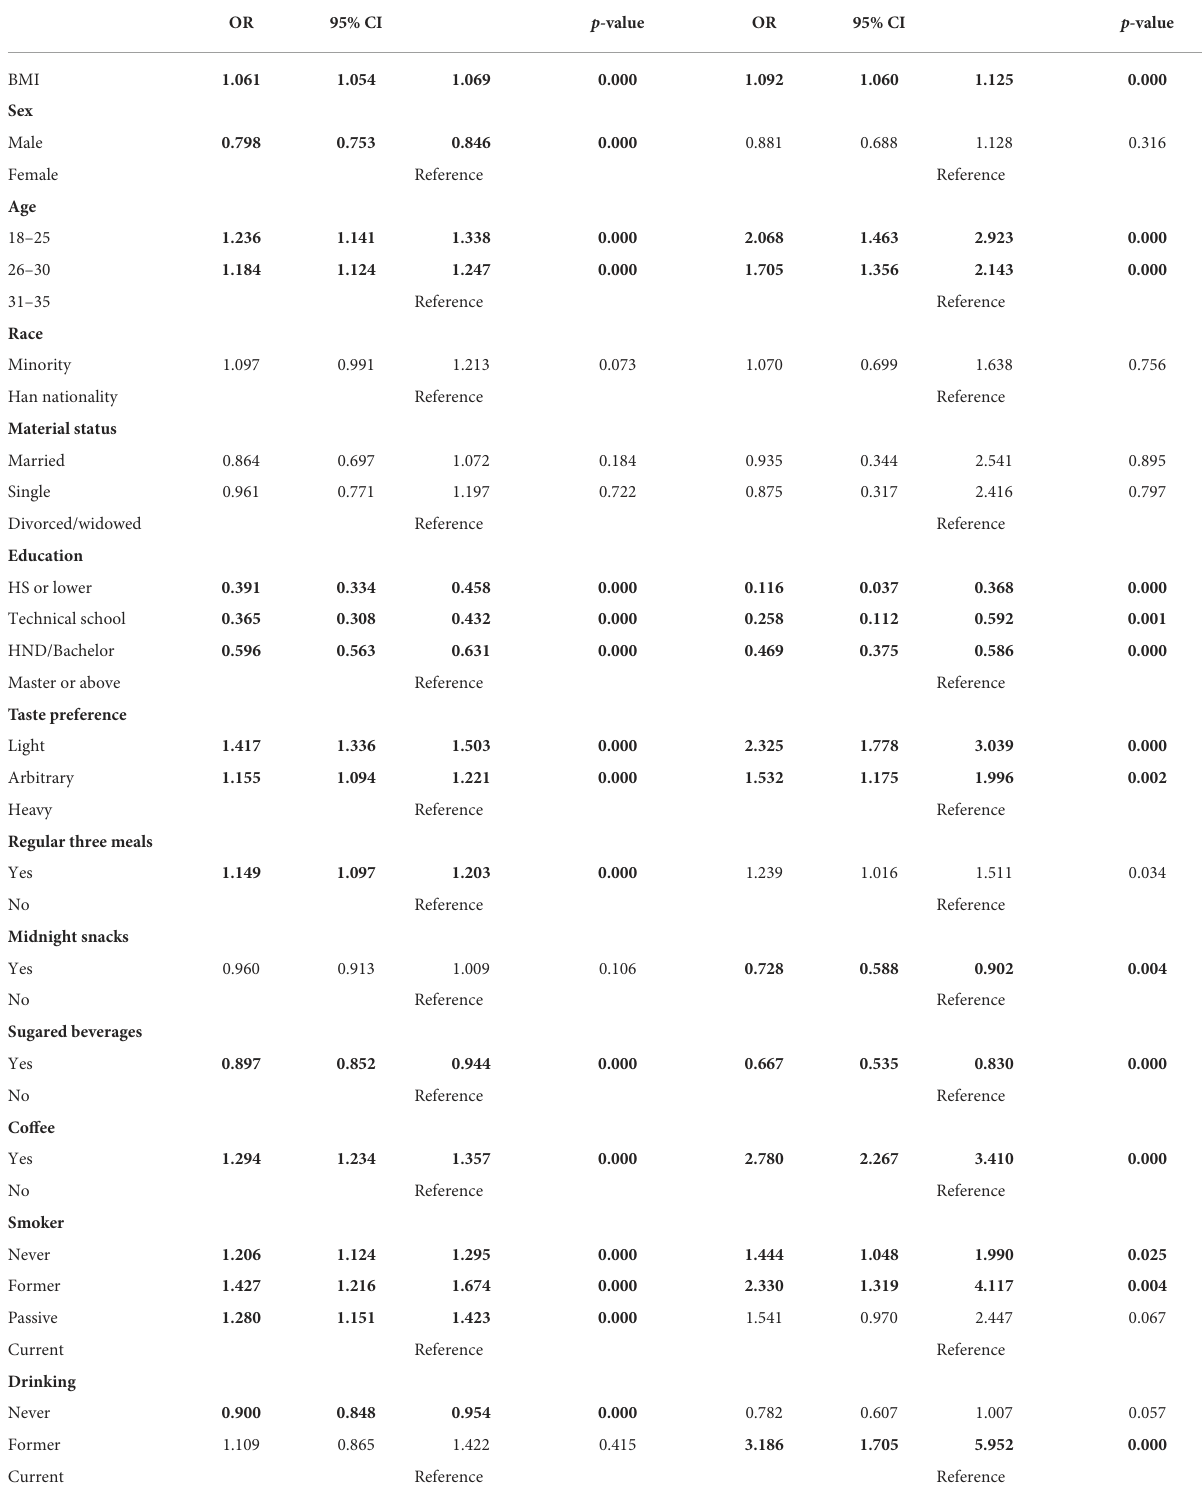
TABLE 3 Unadjusted multinomial logistic regressions of dietary diversity on independent variables ( n = 49,021).